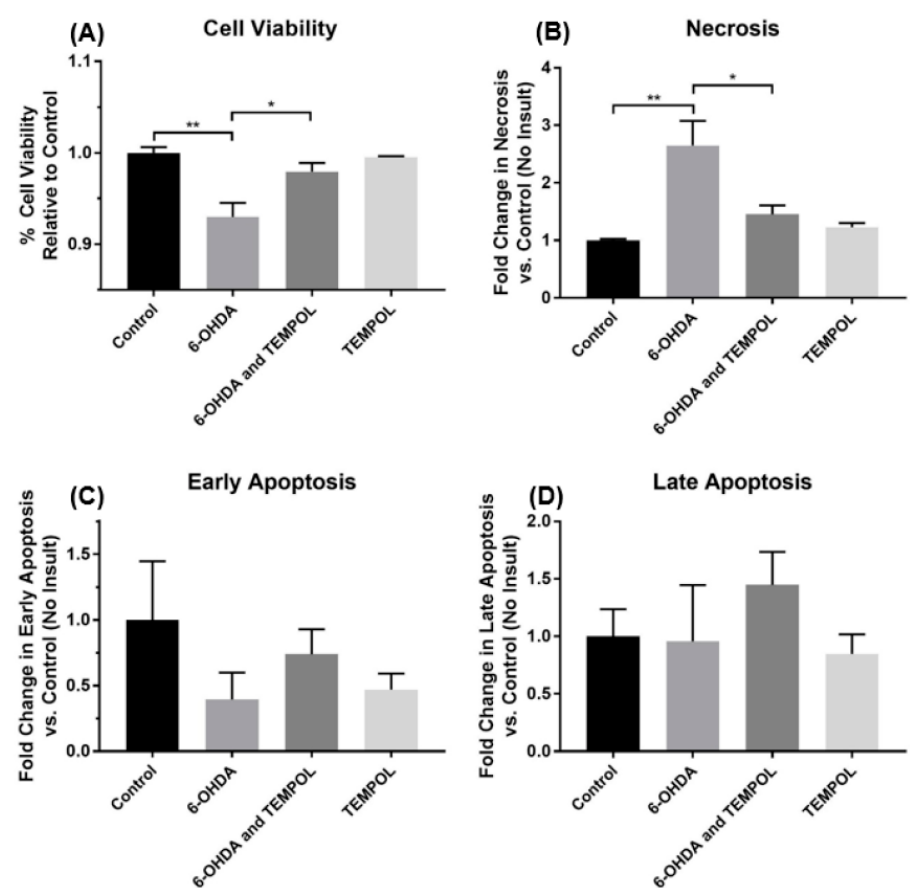
Figure 3. Quantification of SH-SY5Y dopaminergic cell viability after treatment with 6-OHDA ± TEM- Figure POL. Analysis of viable cell populations was identified through analyses with flow cytometry using a